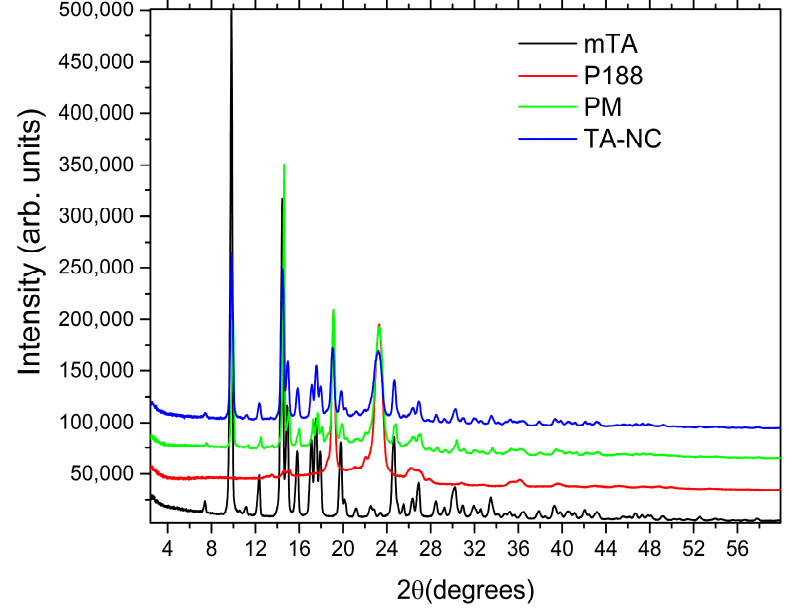
Figure 7. XRPD patterns for mTA, P188, PM and TA-NC.